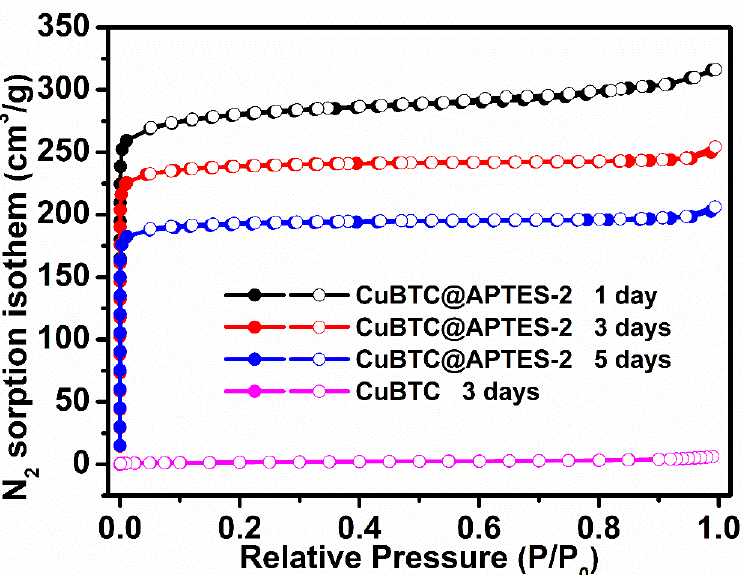
Figure 7. N 2 adsorption–desorption isotherms at 77 K of CuBTC and CuBTC@APTES-2 after submersion in water for several days.